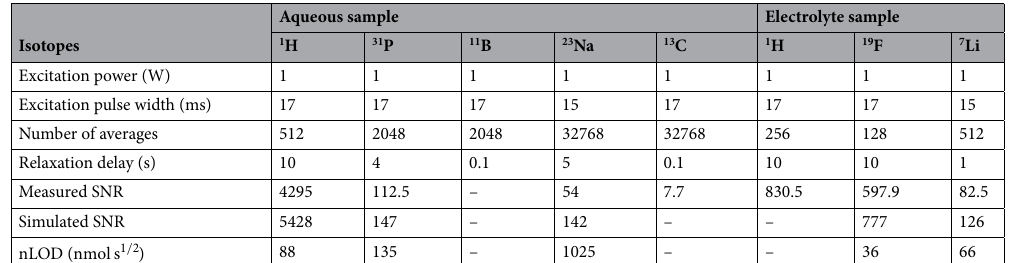
Table 2. NMR experiment results at seven different frequencies prove the broadband performance of the detector. SNR values were scaled to their single-scan equivalent before calculating nLOD. Here, nLOD = SNR, and B 0 is the static magnetic field. The excitation pulse width was defined based on the maximum amplitude of the nutation curve. SNR is calculated in the frequency domain (the ratio between the signal and the rms noise). The excitation pulse width is the same for almost all the nuclei, due to the fact that the impedance of the coil changes linearly with frequency (being dominated by the inductance) and hence the current in the coil compensates for the reduced gyromagnetic ratio. The simulated SNR values extracted from the ’digital twins’ of the spectra given in Fig.